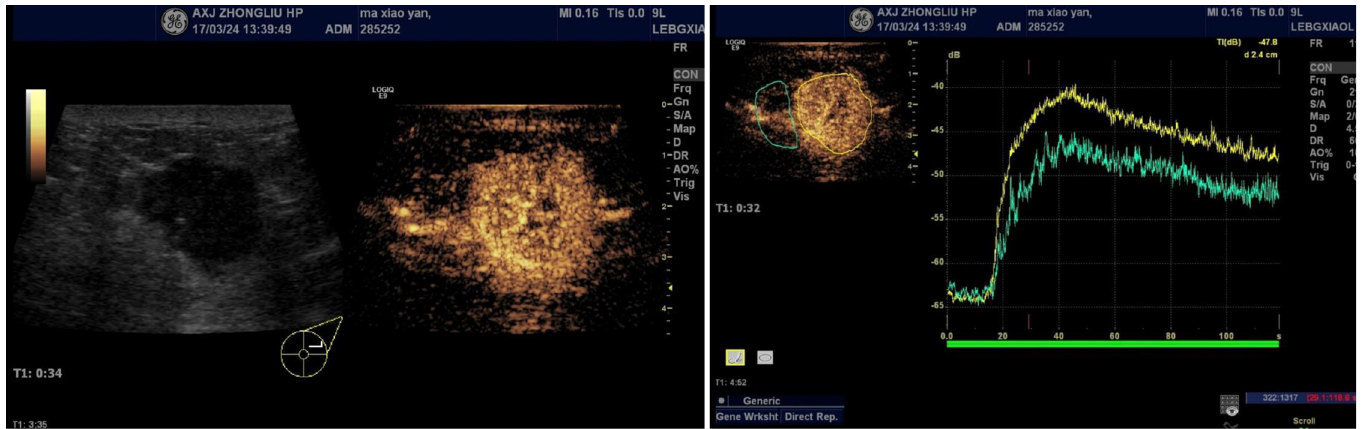
Fig 5. Contrast-enhanced ultrasound (CEUS) of breast cancer. The representative image of the CEUS in breast cancer was shown, with enlarged lesion range (expanding beyond that of the 2D ultrasound). Perfusion defect could be seen in the central area. Compared with the normal surrounding tissue, the TIC showed the fast- in pattern and high